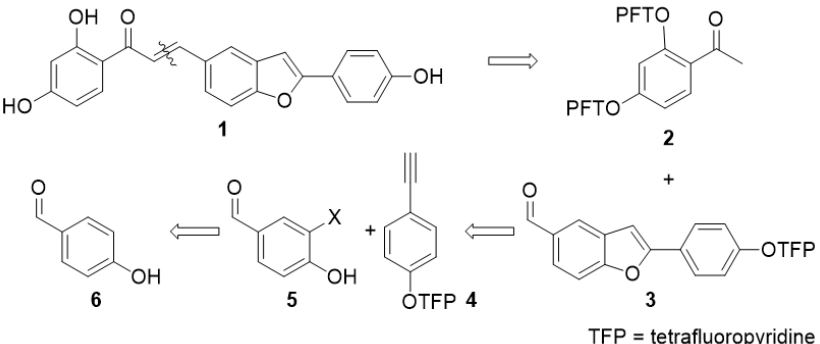
Figure 2. Retrosynthetic analysis for natural chalcone 1